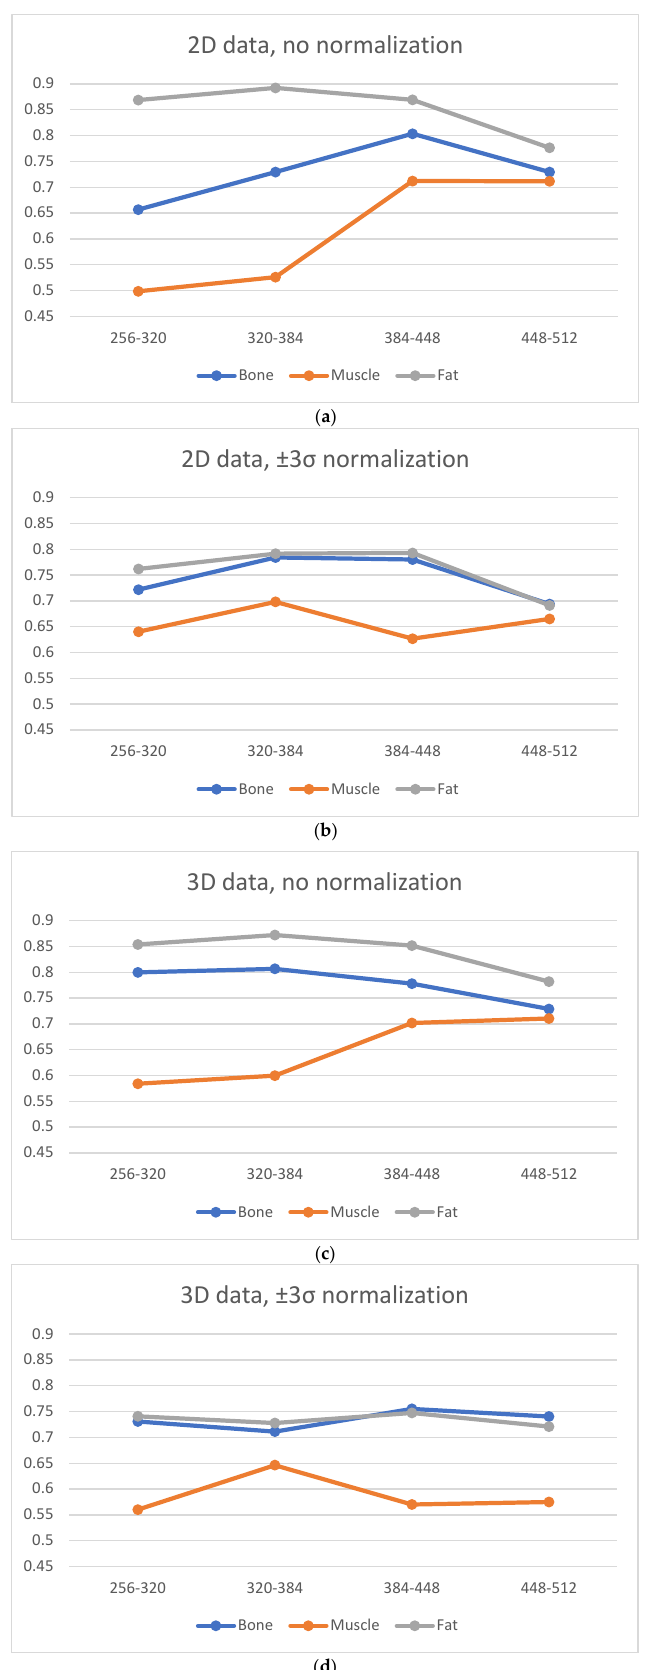
Figure 6. Average Lin’s coefficients for all texture features evaluated between neighboring matri- ces.